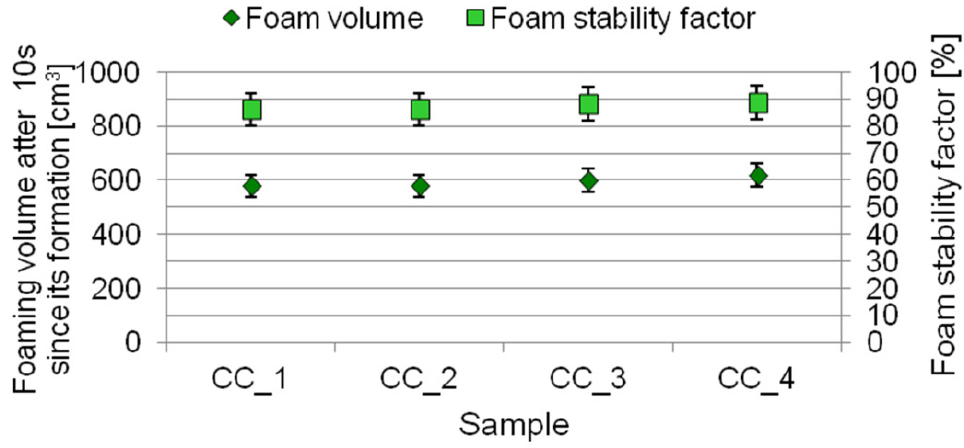
Figure 8. Foaming ability of shower gels containing digestate extract.